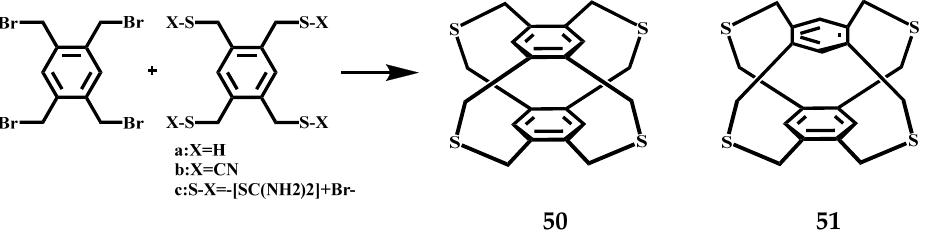
Figure 22. Synthesis of tetrathiacyclophanes 50 and 51 .